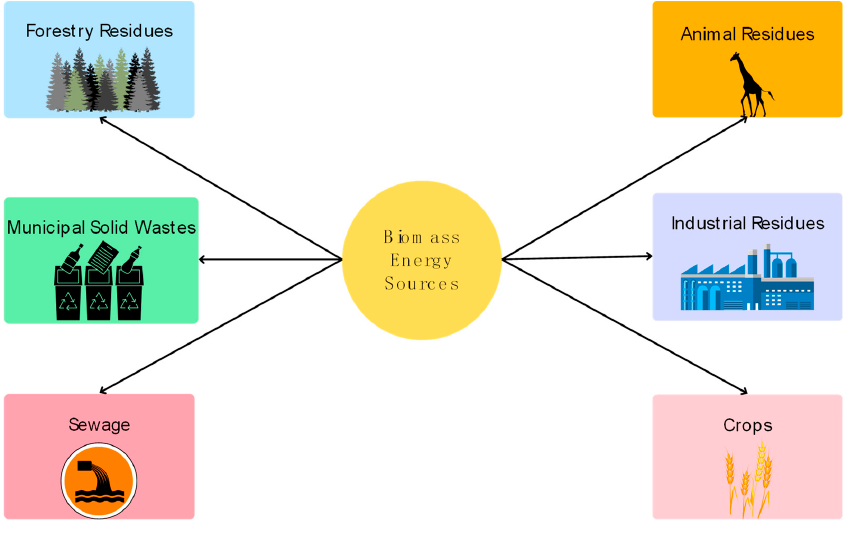
Figure 5. Biomass energy sources.